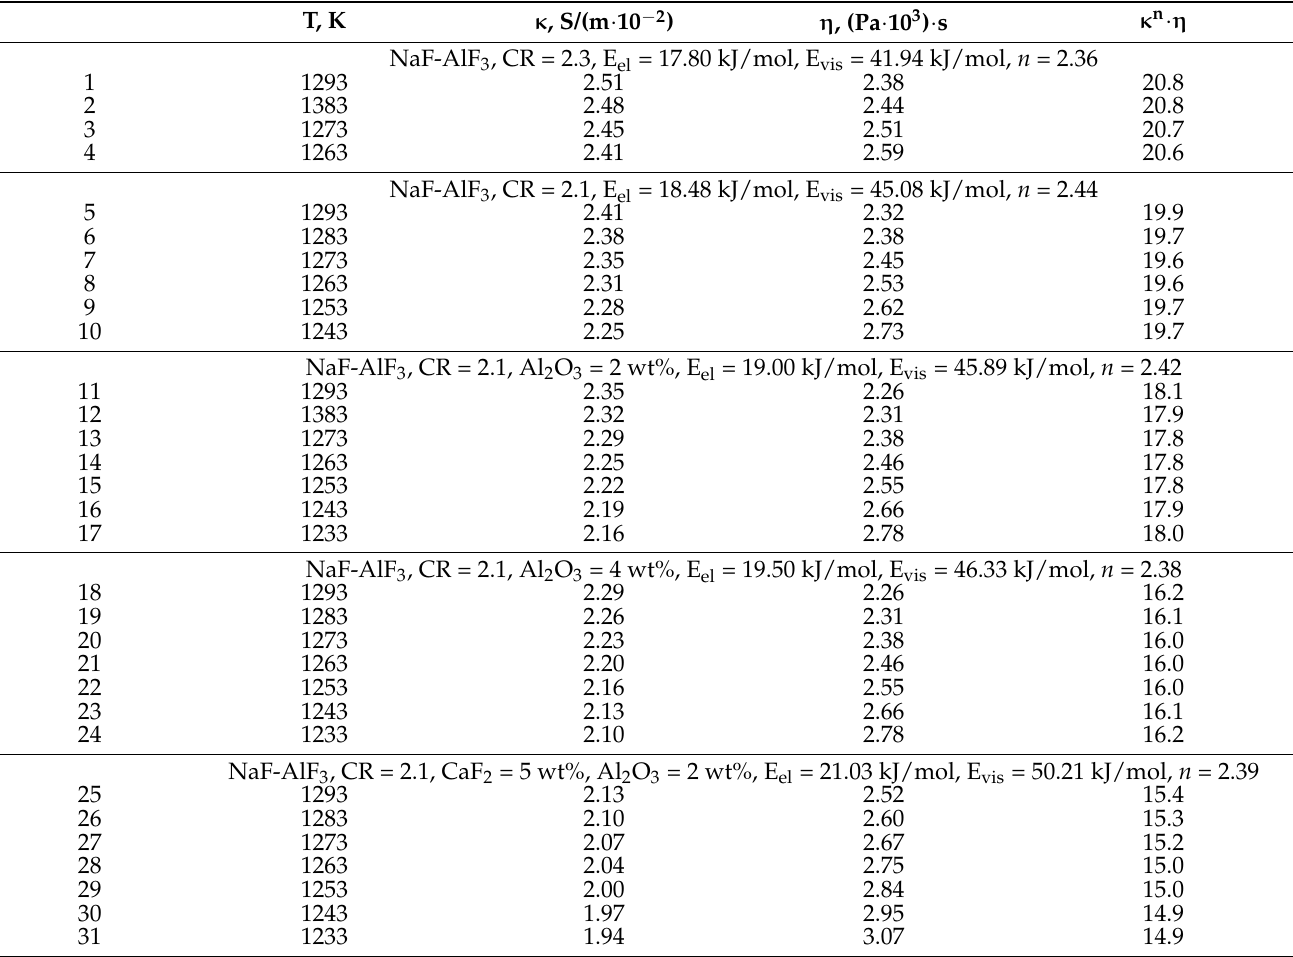
Table 2. Relationship between the electrical conductivity and the viscosity of cryolite melts. T,